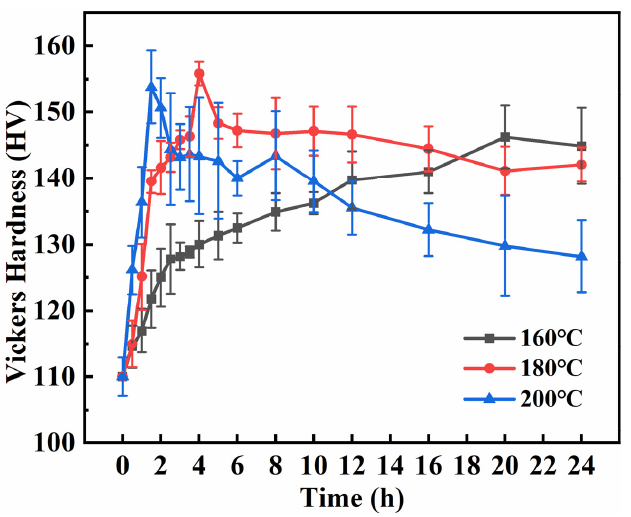
Figure 11. Effect of ageing time at different temperatures on microhardness of Al-Si alloy.